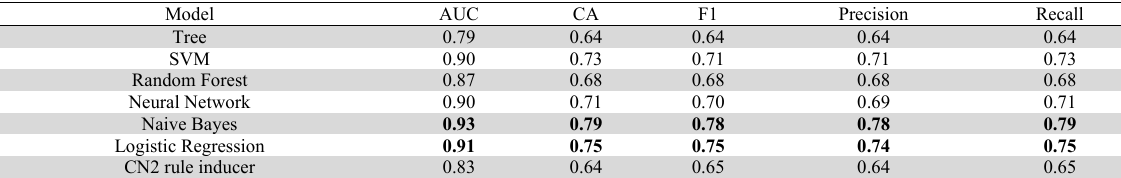
Results for usability quality